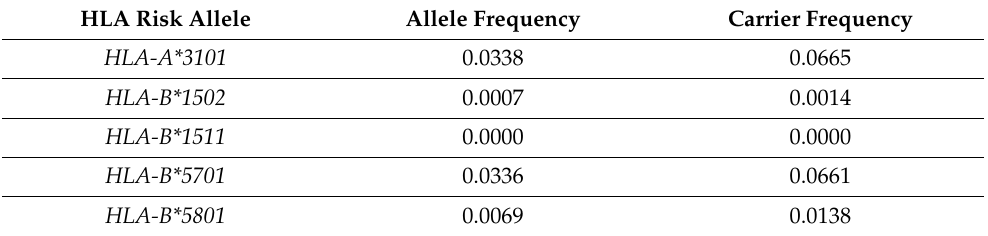
Table 2. Allele frequencies and carrier frequencies of HLA risk alleles in the Dutch population [17,18].